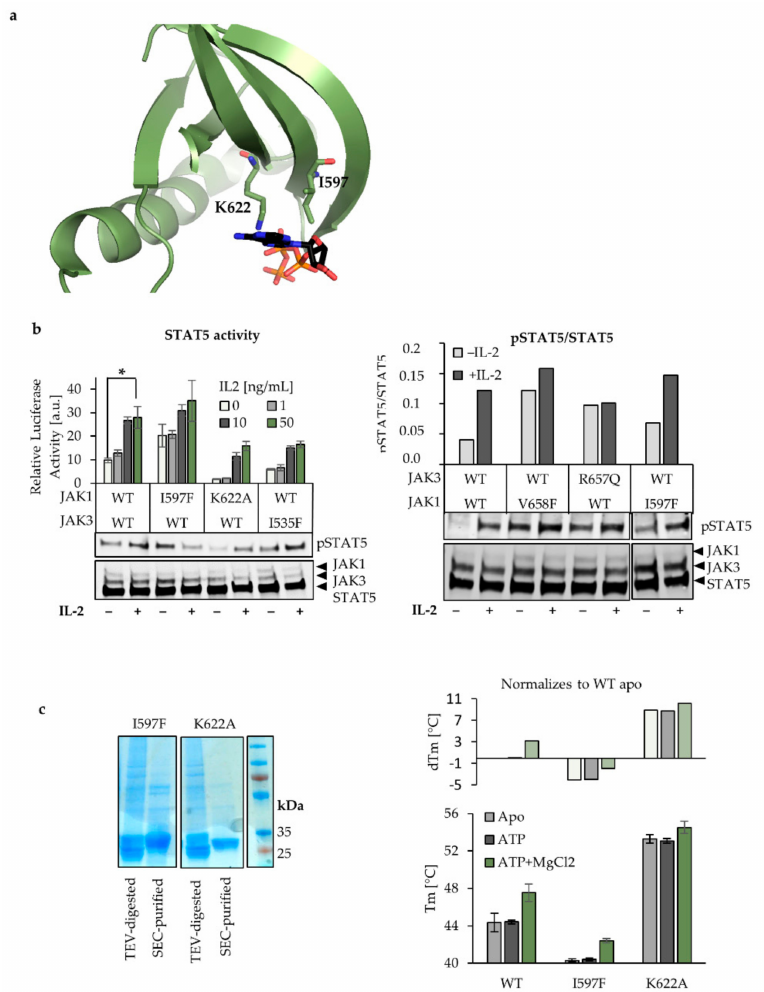
Figure 3. Characterization of the JAK1 JH2 ATP-binding site mutants. ( a ) Illustration of the JAK1 JH2 ATP-binding pocket, including the α C-helix of (PDB 4L00). The mutated residues K622 and I597 are shown, as well as ATP. ( b ) JAK1 I597F slightly increases the basal STAT5 activity and is responding to IL-2. JAK1 K622A shows reduced but cytokine-responsive STAT activation. STAT5 responsive luciferase system was used as previously described in U4C γβ cells transfected with JAK1 and JAK3 JH2 ATP-site mutants or JAK WT. The errors are SD triplicate samples. Below : pSTAT5- and HA- labeled cell lysates from basal, and cytokine treated cells. Two-tailed t -test was performed and p < 0.05 is indicated as *. Right : comparison of JAK1 I597F with WT and hyperactive JAK1 and JAK3. Immunoblots from whole-cell lysates were labelled with HA (JAK1 / JAK3 / STAT5) and pSTAT5 antibodies to detect the pSTAT5 / STAT5 ratios for basal and IL-2 stimulated (100 ng / mL) cells. ( c ) Recombinant JAK1 JH2 mutants vary in their stability. Di ff erential scanning fluorimetry (DSF) analysis of size-exclusion chromatography (SEC)-purified JAK1 JH2 proteins show that JAK1 I597F has lower Tm compared to WT, while K622A increases Tm. Left : the SDS page gels with JAK1 JH2 elutions before- and after SEC purification. The size of the JAK1 JH2 is ~34 kDa. Right: DSF analysis showing protein Tm − /+ ATP and − /+ MgCl2. Errors are SD ( n = 6). Graph above presents the dTm that is normalized to the wild-type JAK1 JH2 in its apo-form (protein that does not bind any